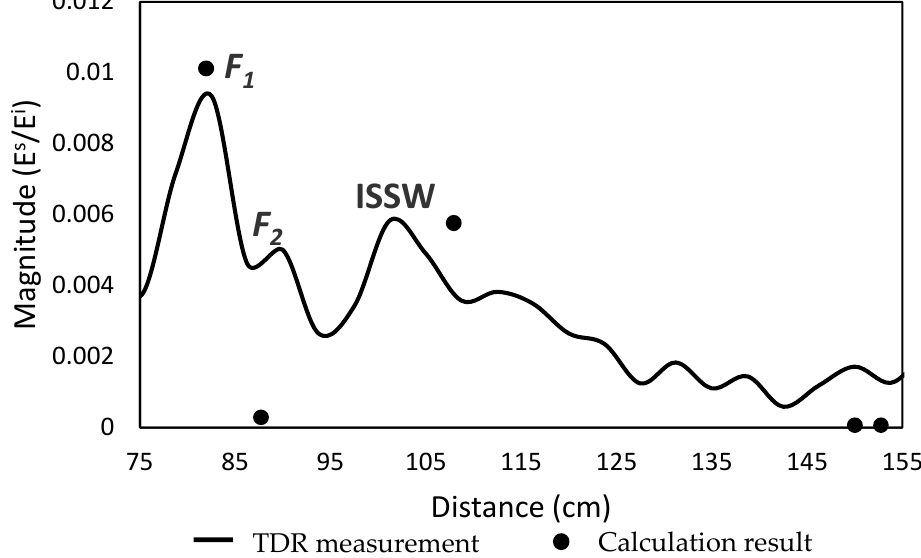
Figure 10. Time-domain response of the backscattered wave from LCS 4.